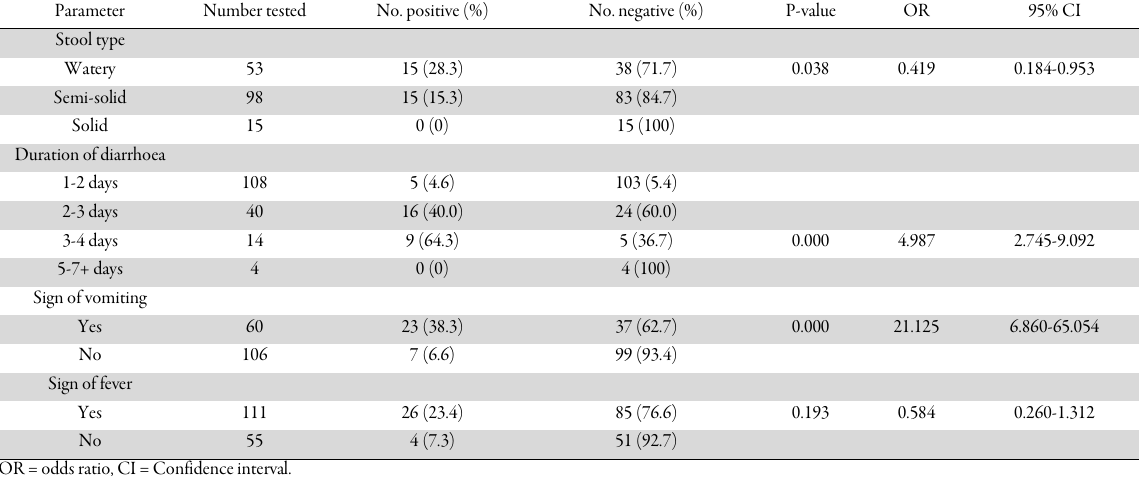
Table 5. Prevalence of Rotavirus group A infection in diarrheic children in relation to some clinical signs in Yobe state, Nigeria